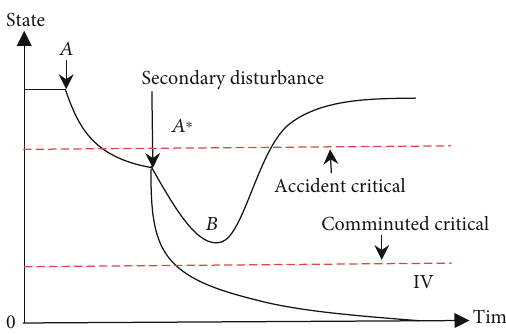
Figure 5: Secondary disturbance system state curves.